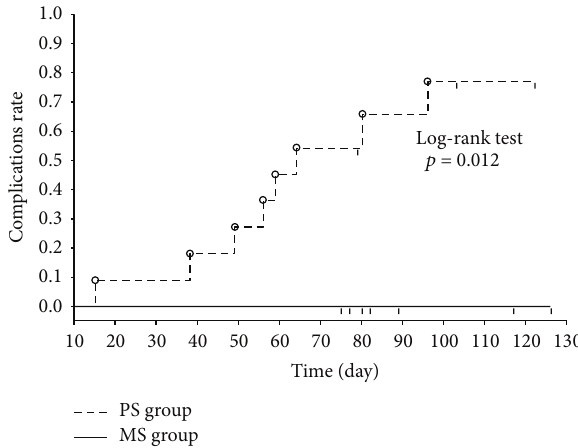
Figure 3: Cumulative rate of complications by stent type. Cumula- tive rate of complications was investigated using the Kaplan-Meier method. The rate of complications on day 60 was 45% for PS and 0% for MS. On day 90, it was 60% for PS and 0% for MS. Cumulative rate for complications was significantly lower for MS than for PS. Statistical analysis was performed using the log-rank test. MS, metallic stent; PS, plastic stent. The solid line is the MS group; the wavy line is the PS